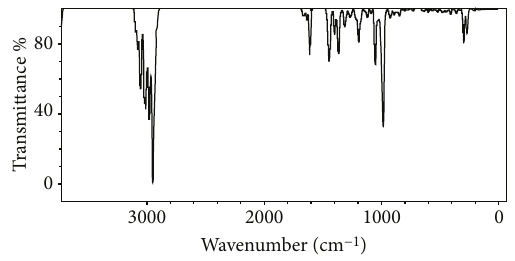
Figure 3: BCRY-MeOH theoretical IR